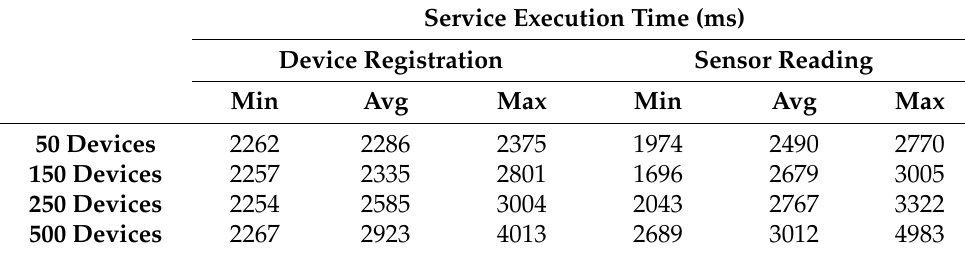
Table 5. Performance Analysis of Blockchain-based IoE